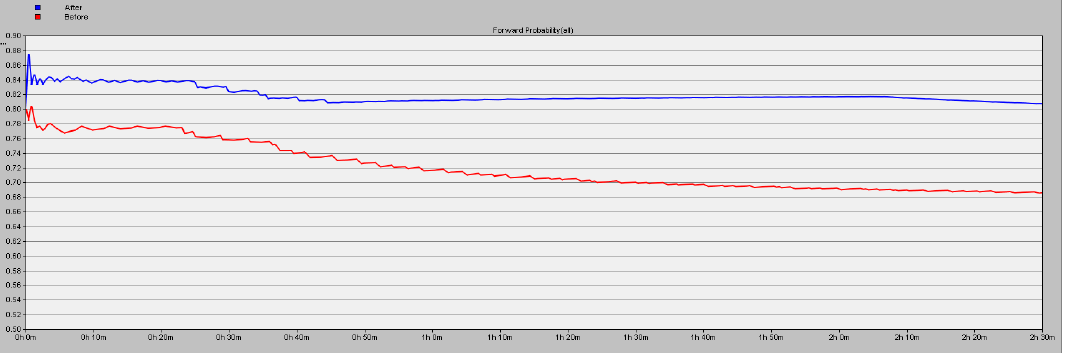
Figure 10. Forward probability of the network with two malicious nodes.